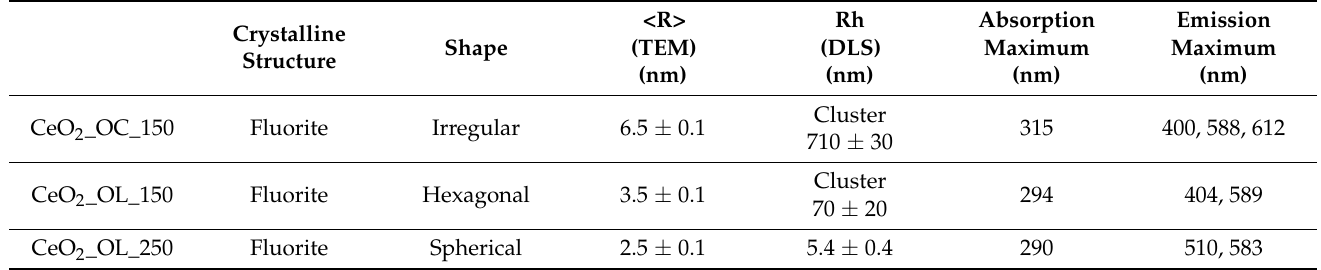
Table 4. CeO 2 NP structural and spectroscopic